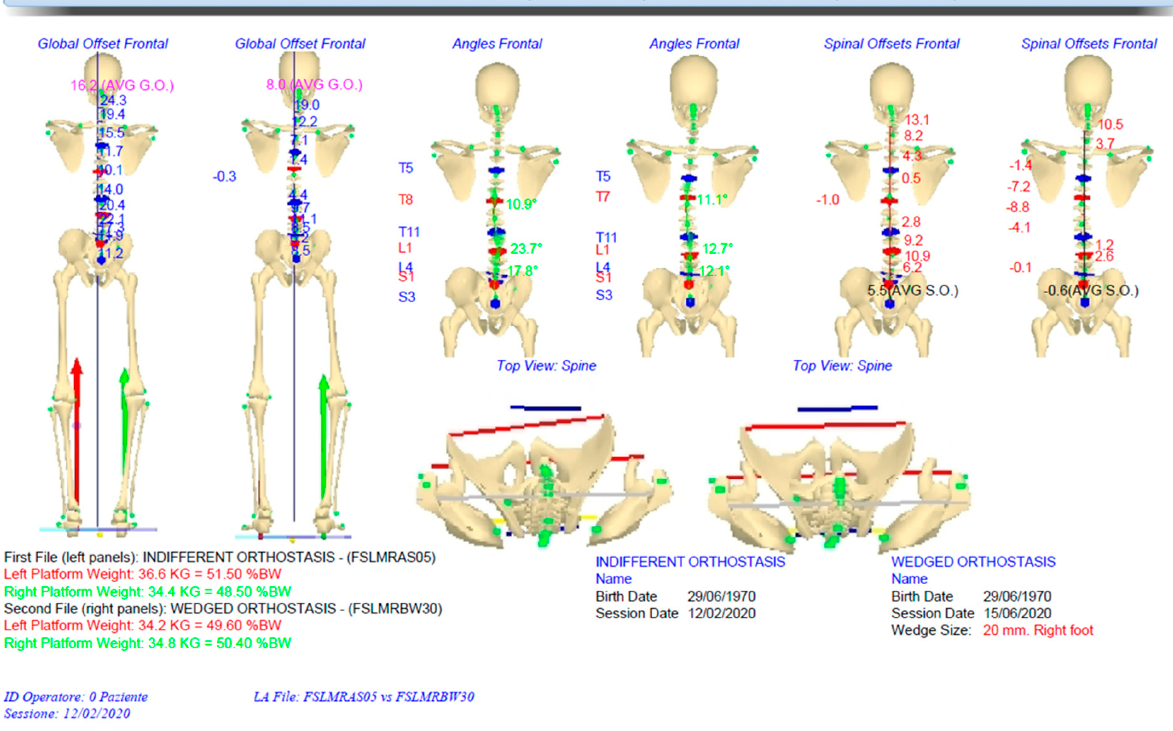
Figure 6. Comparison between IO at first evaluation vs. WCO at control after a 4-month rehabilitation period. (See text and Figure 4 caption for the definition of spinal and global offsets.)